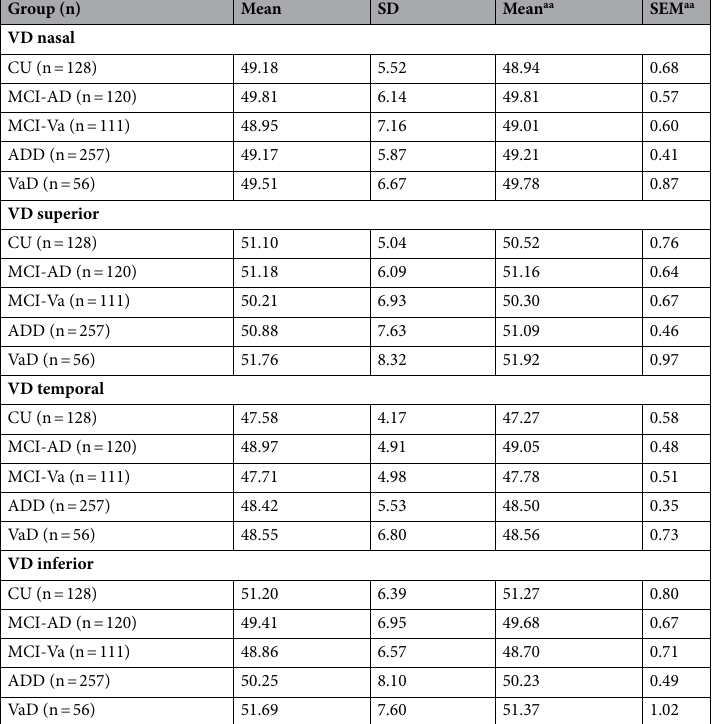
Table 3. Raw and adjusted macular VD differences across diagnostic groups. Raw and adjusted macular VD means, standard deviation (SD) and standard error of the mean (SEM) are shown. Dispersion is shown as SEM. aa = after adjustment for the following factors: age, sex, years of education, hypertension, diabetes mellitus, heart disease and stroke, using multivariate regression analysis. ADD = probable Alzheimer´s disease dementia; CU = cognitively unimpaired; MCI-AD = mild cognitive impairment due to Alzheimer´s disease; MCI-Va = mild cognitive impairment due to cerebrovascular pathology; SD = standard deviation; SEM = standard error of the mean; VaD = vascular dementia; VD = vessel density. Statistical significance was set up at p <